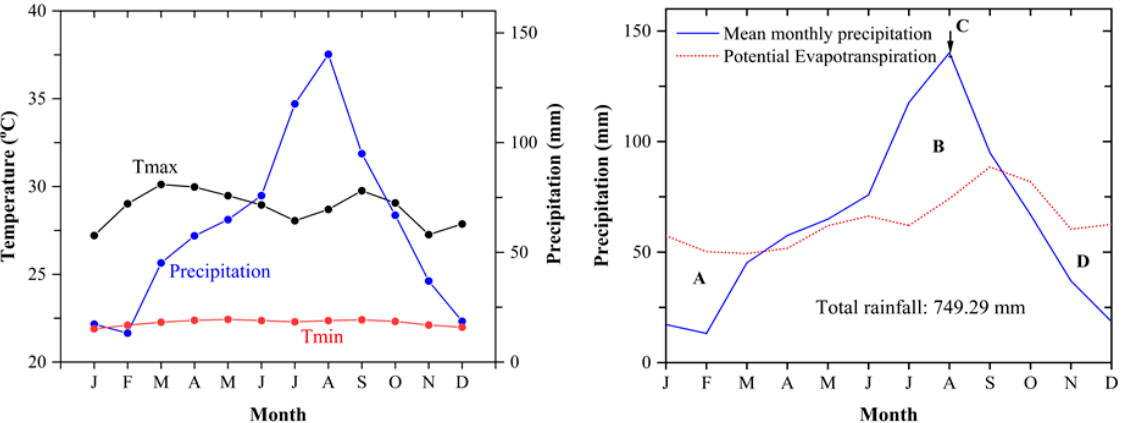
Figure 7. Model of water budget in the NRB for the year 2020. A and D: Climatic Water Deficit (CWD): The potential evapotranspiration is greater than precipitation. The water store is being used up by plants of lost through evaporation (soil moisture utilization). As the store of water is depleted, and potential evapotranspiration exceeds precipitation, there is a deficiency of soil water. Crops must have adaptation behaviors and they must be irrigated. B: Water Surplus: Precipitation exceeds potential evapotranspiration. The soil water store is full and there is a soil moisture surplus for plant use, runoff, and groundwater recharge. C: Field capacity has been reached. Additional rainfall will percolate down to the water table, and groundwater stores will be recharged.